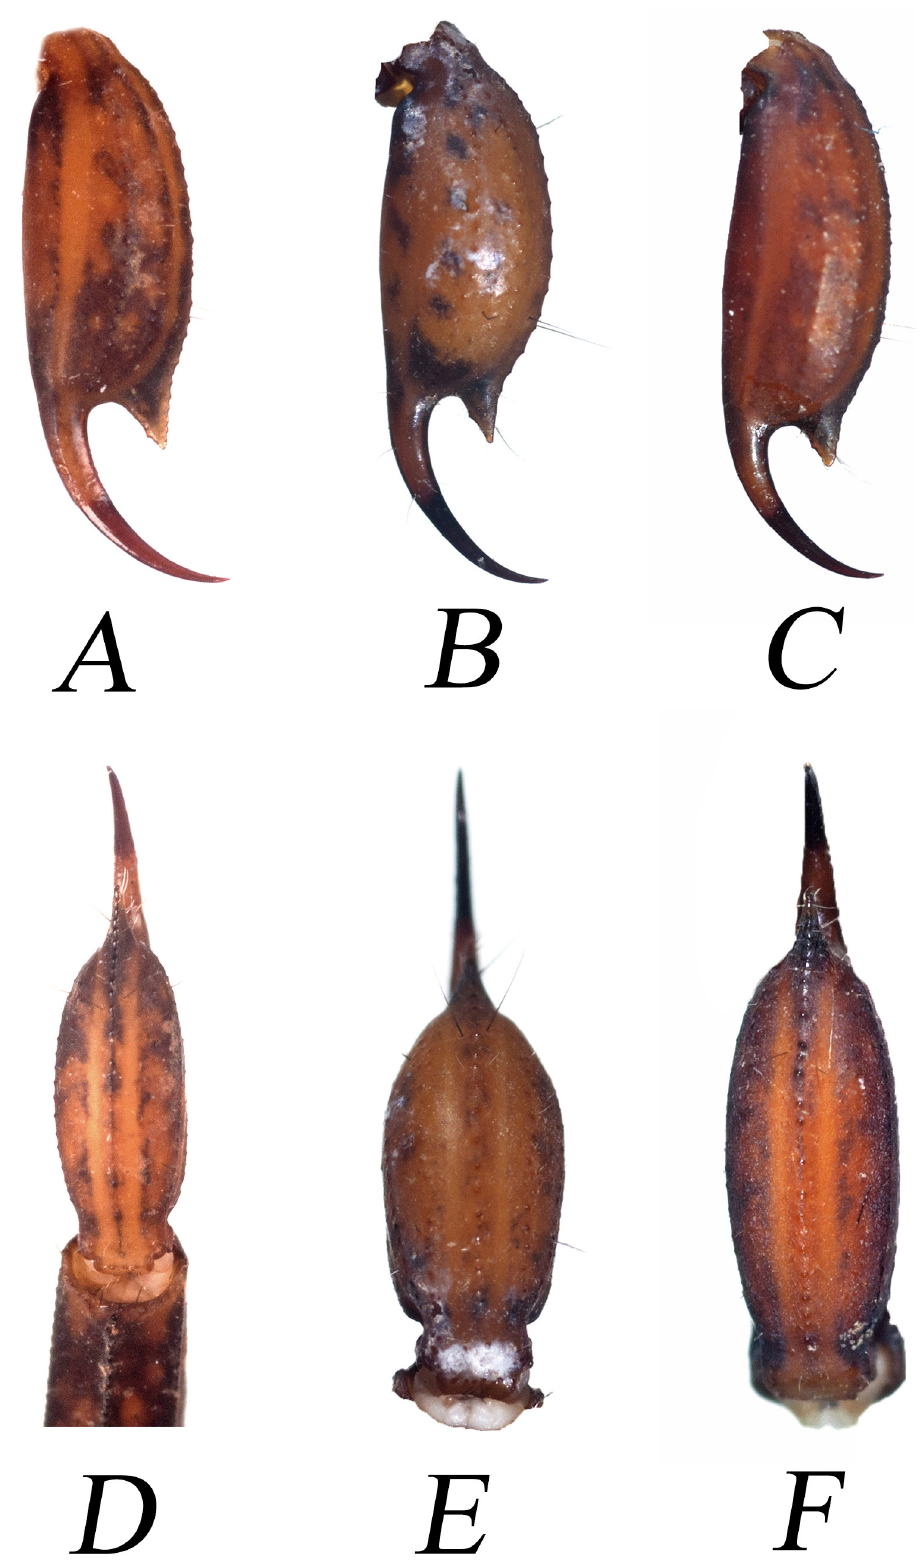
Fig. 19. A – C . Telson in lateral view. D – F . Telson in ventral view. A, D . Isometrus sankeriensis Tikader & Bastawade, 1983, neotype, adult ♂ (BNHS SC 194). B, E . I. nakshatra sp. nov., holotype, adult ♂ (BNHS SC 195). C, F . I. wayanadensis sp. nov., holotype, adult ♂ (BNHS SC